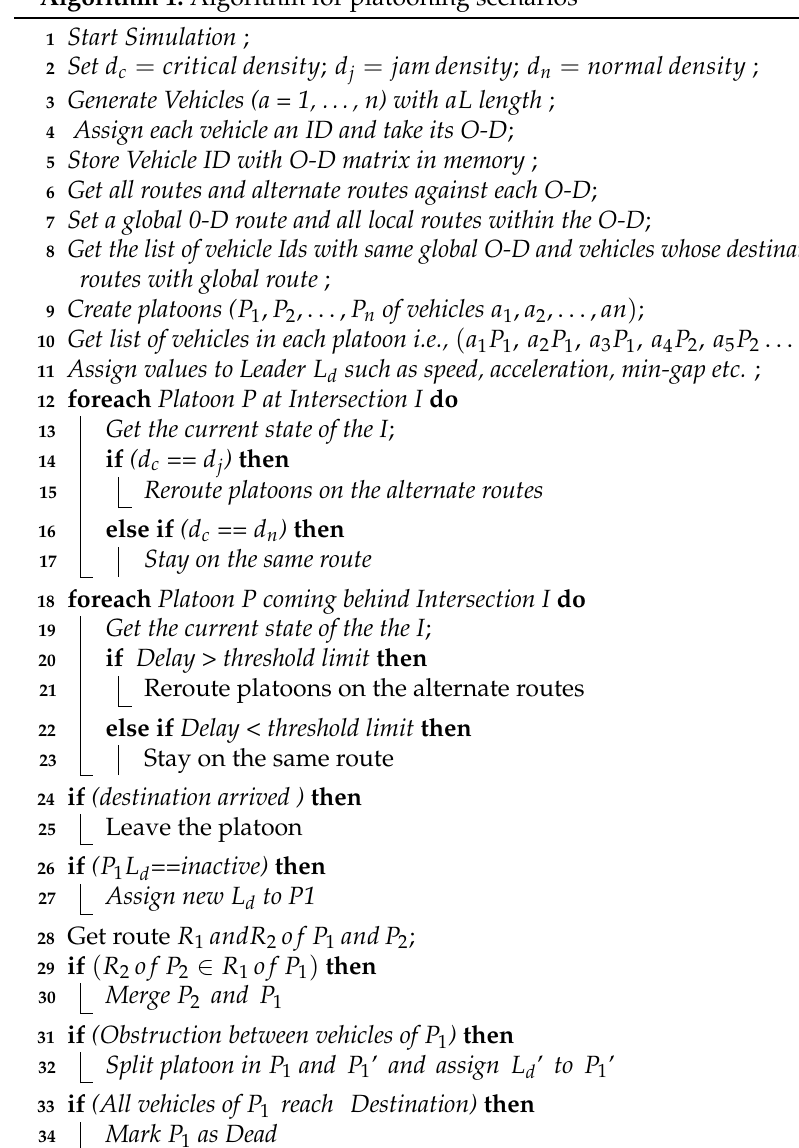
Algorithm 1: Algorithm for platooning